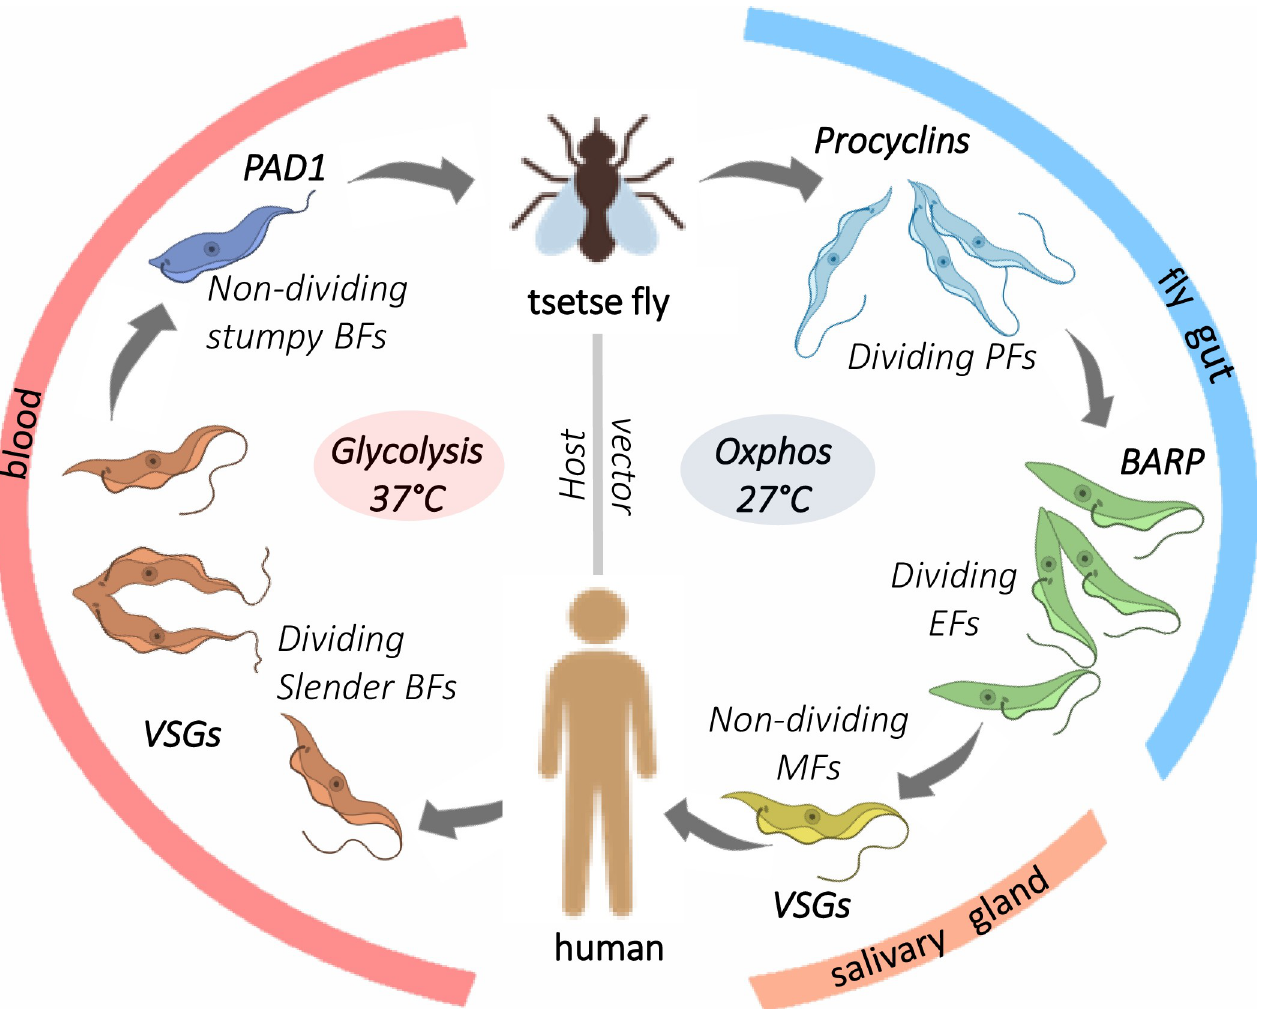
Fig 1. brucei life cycle indicating characteristic gene expression differences between the stages. Diagram of T . The slender BFs proliferate in the blood, express VSGs, and metabolize glucose as the main energy source and develop into nondividing stumpy BFs that cease VSG expression and express PAD1. The stumpy forms develop into PFs that proliferate in the fly gut, express EPs and GPEETs, and primarily generate energy via oxphos. The PFs develop into EFs in the salivary gland that express BARPs and subsequently develop into infective MFs that resume VSG expression. BARPs, brucei alanine-rich proteins; BFs, bloodstream forms; EFs, epimastigote forms; EPs, procyclin rich in Glu-Pro repeats; GPEETs, procyclin rich in Glu-Pro-Glu-Glu-Thr repeats; MFs, metacyclic forms; oxphos, oxidative phosphorylation; PAD1, proteins associated with differentiation 1; PFs, procyclic forms; VSGs, variant surface glycoproteins.